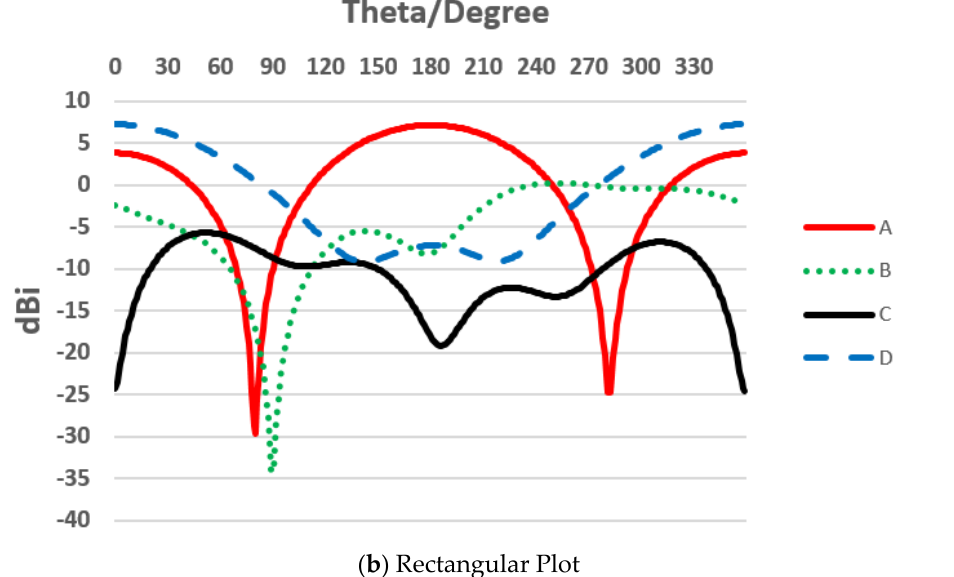
Figure 4. Radiation pattern of tag antenna. Table 2. Beam angle vs. parameters.